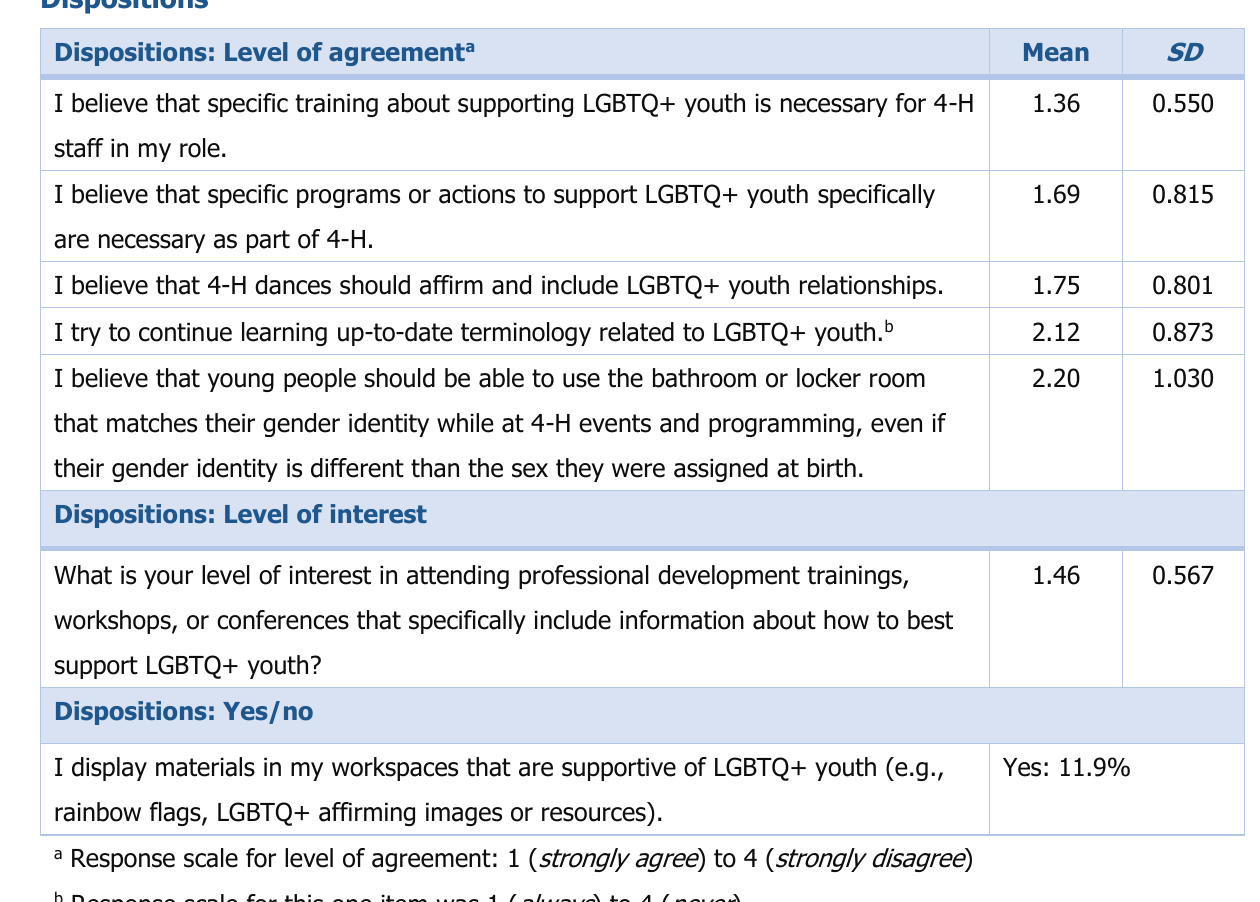
Table 4. Means and Standard Deviations of Respon dents’ Ratings on